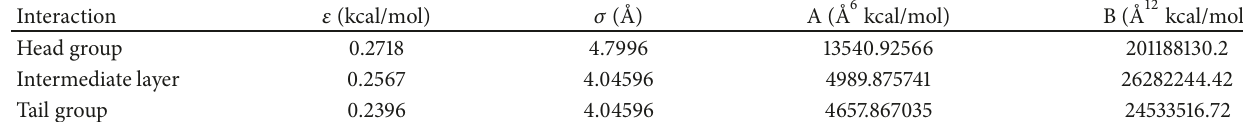
Table 2: Lennard-Jones parameters for DPPC lipid interacting with DNA [23, 24].